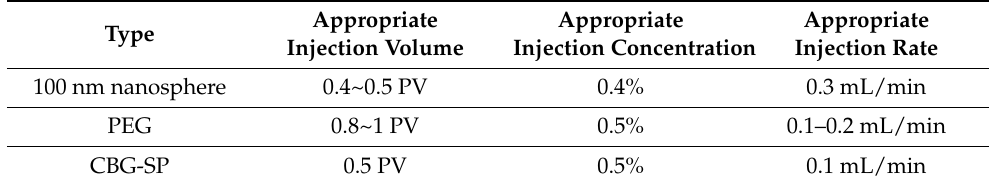
Table 14: Table 14. Suitable parameters of PCAs in low-permeability fractured